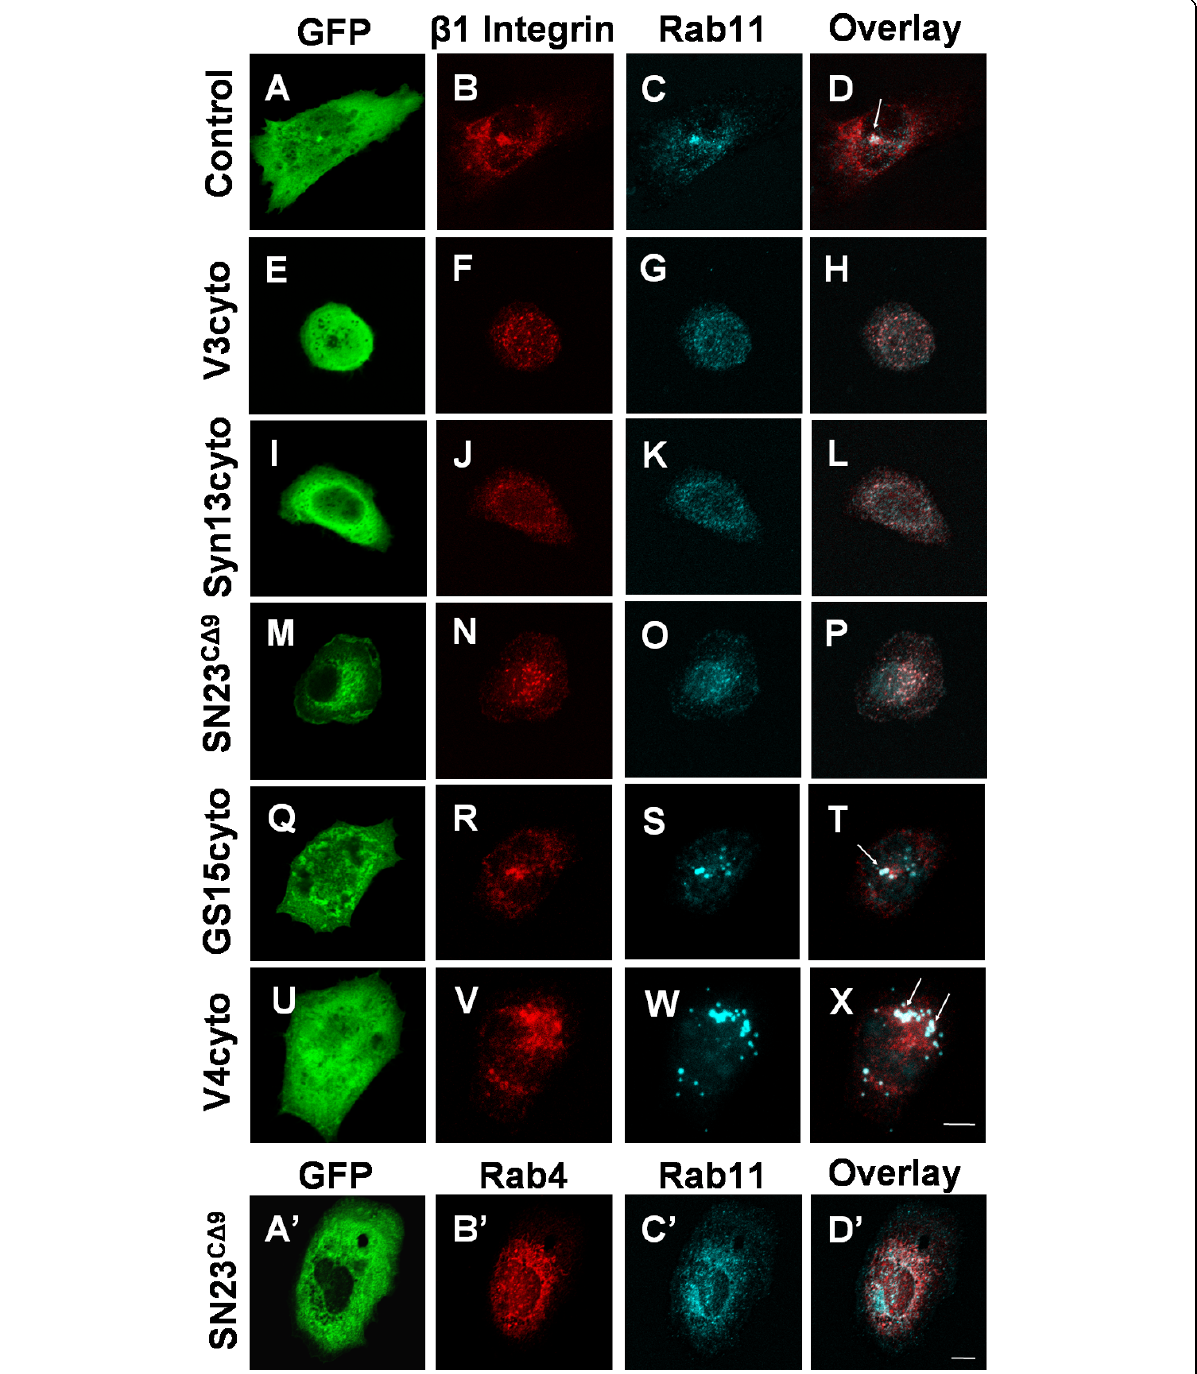
Figure 5 Dominant-negative SNARE domains disrupt b 1 integrin trafficking into the recycling endosome . CHO-K1 cells were transiently transfected for 22 h with GFP [A-D] or GFP-tagged constructs of truncated VAMP3 (V3cyto) [E-H], syntaxin13 (Syn13cyto) [I-L], SNAP23 (SNAP23 C Δ 9 - 15 h transfection) [M-P, A ’ -D ’ ], GS15 (GS15cyto) [Q-T], or VAMP4 (V4cyto) [U-X]. Cells were labeled with anti- b 1 integrin antibody in serum free medium for 1 h to allow internalization of integrin-antibody complexes. Cells were then washed in 0.2 M glycine, pH 2.5, fixed, and stained for Rab11 [C, G, K, O, S, W and C ’ ] and the intracellular integrin-antibody complexes [B, F, J, N, R, and V], or Rab4 [B ’ ]. Overlays of the Rab11 and b 1 integrin staining are shown in D, H, L, P, T and X, and Rab4 and Rab11 overlays are shown in D ’ . Arrows indicate conventional colocalization of b 1 integrin in a central Rab11-containing compartment. Images are 3 D reconstructions of a z-series. Scale bar represents 10 μ